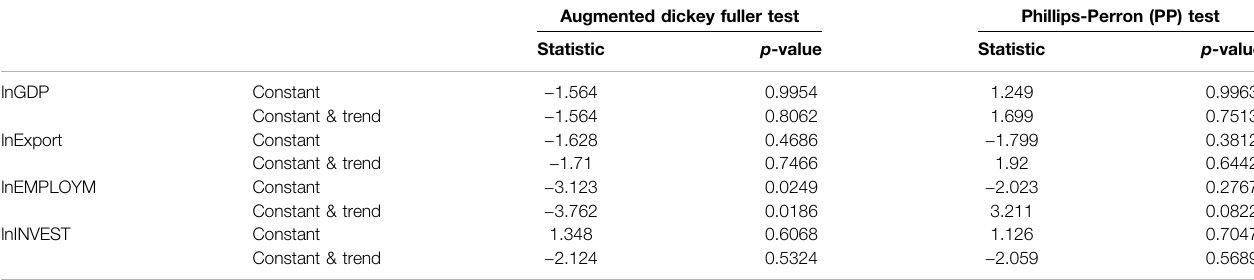
TABLE 3 | The model variables were subjected to augmented Dickey-Fuller (ADF) and Phillips-Perron (PP) unit root tests.